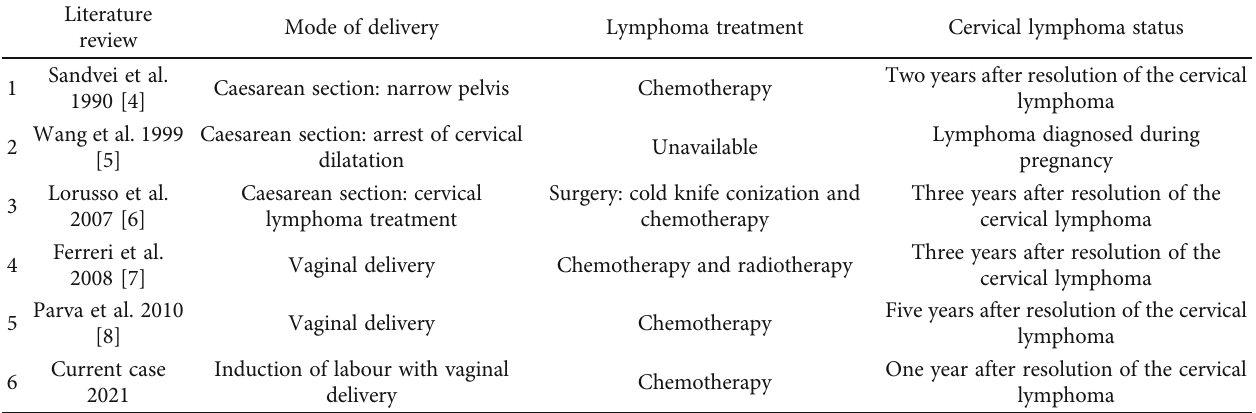
Table 2: Mode of delivery in women a ff ected by cervical lymphoma, literature